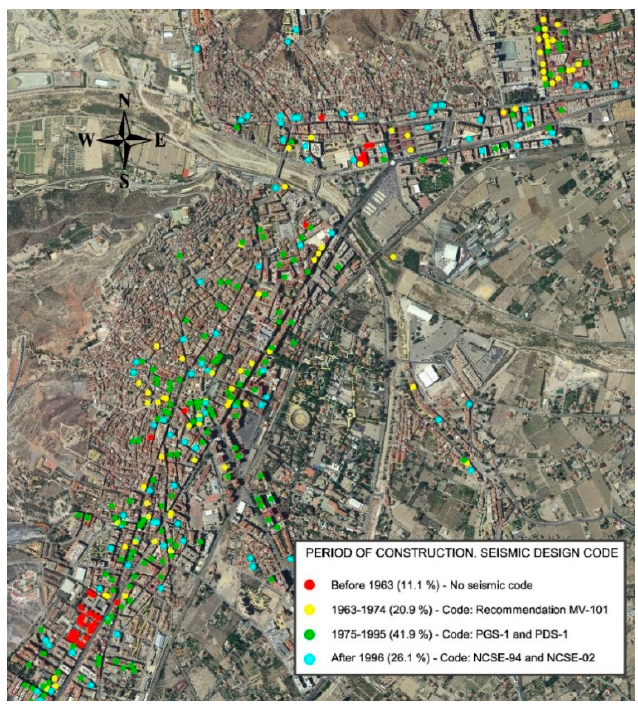
Figure 2. Graphical construction period distribution of the buildings evaluated in Lorca, according to the different Spanish seismic codes that exist.